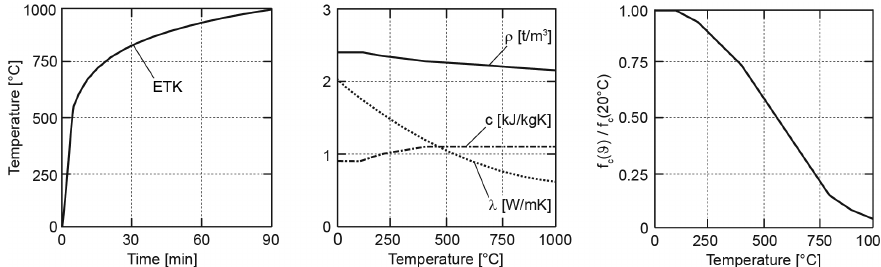
Fig. 6. Development of the outside temperature level (left), temperature dependent thermal material parameters (middle) and mechanical material parameters of concrete